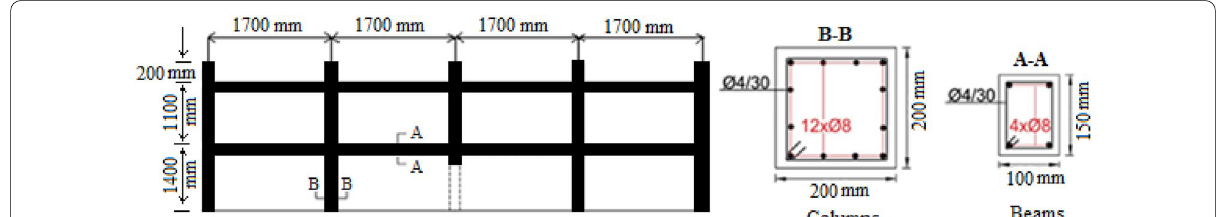
Fig. 1 The geometry and reinforcement layout of the reference model examined by Li et al. (2016).